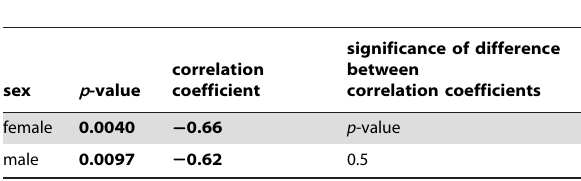
Table 2. Correlation values and permutation results for serum neuron-specific enolase and averaged smoothed gray matter density in the